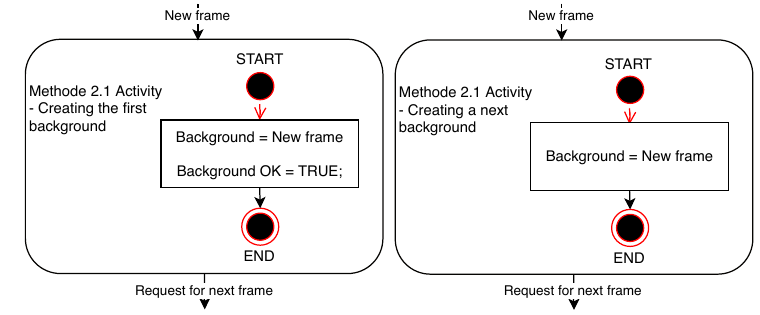
Figure 10. Diagrams of Method 2.1 activity.